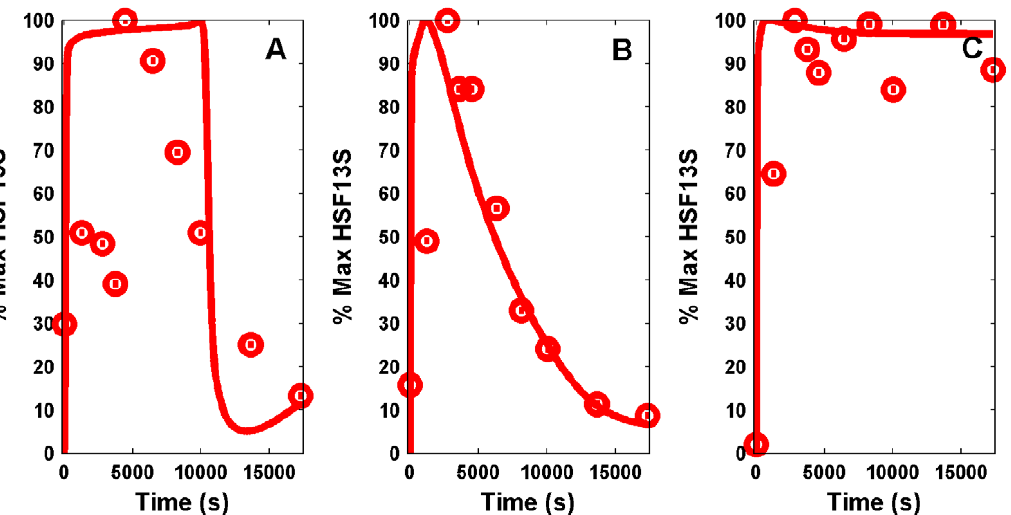
Figure 2. Simulated and experimental time series of heat-shock factor 1 (HSF1) trimer. In the experiments [24], the time courses of HSF levels were obtained for three different temperatures, namely, 41 o C , 42 o C , and 43 o C , shown in red circles in (A), (B), and (C), respectively. For a very high temperature ( 43 o C ), HSF levels reach a new steady state. Fitted time series of HSF13S levels (continuous line) are shown for three different k stress that correspond to the stress values of (A) 0.4136, (B) 0.9859, and (C) 1.2066. The percent conversion of the time series is calculated as all the dynamical variables, and Y is both experimental and simulated time series.